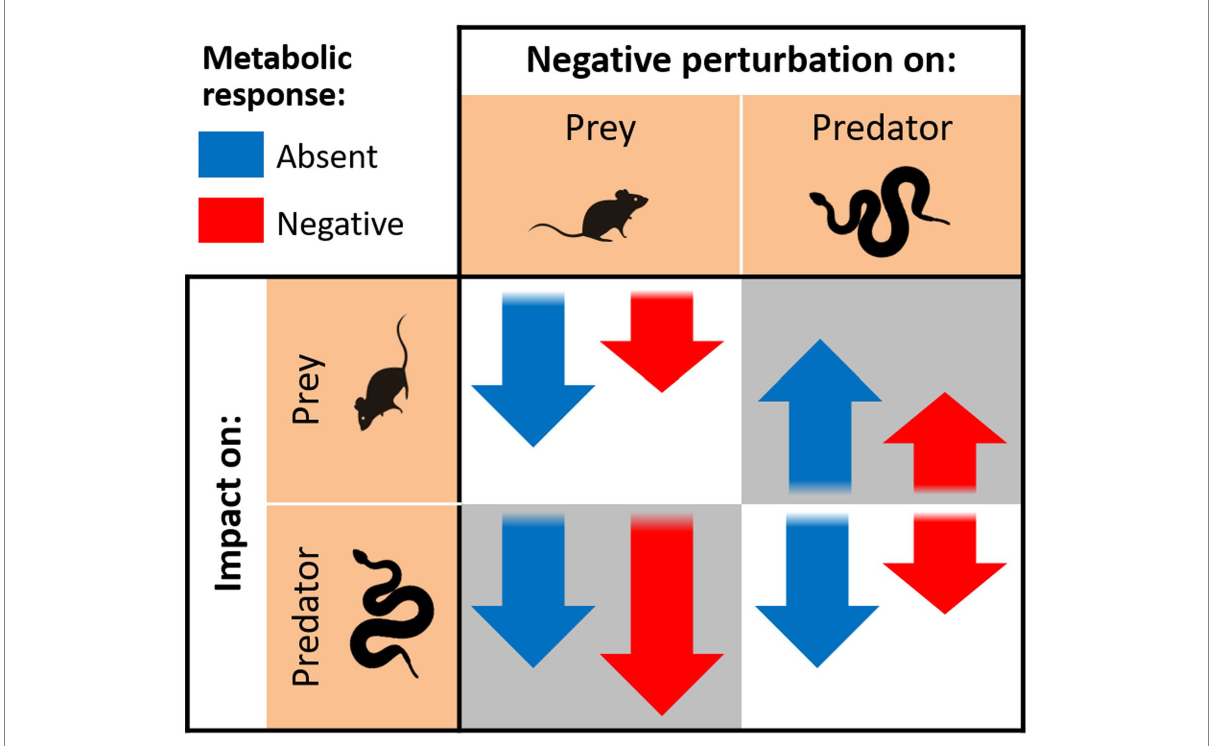
FIGURE 3 Schematic representation of impacts of negative press perturbations on the equilibrium population sizes of predator and prey. Downward pointing arrows represent negative impacts (declining population) and upward arrows represent positive impacts (increasing population). Arrow sizes represent relative magnitude of impacts, and arrow colors distinguish a scenario without a metabolic response (blue) versus a scenario with a negative metabolic response (red). The background identifies the type of impact, whether direct (white background) or a trophic cascade